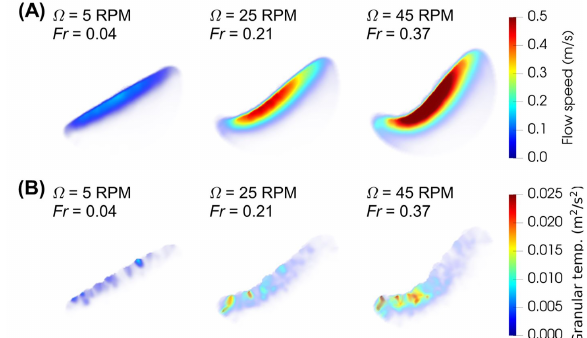
Figure 3. A) flow speed, and B) granular temperature averaged over the last 0.3 seconds of the DEM simulations of the dry case at various rotation speeds. The white zone below the flowing layer indicates particles at rest in the rotating reference